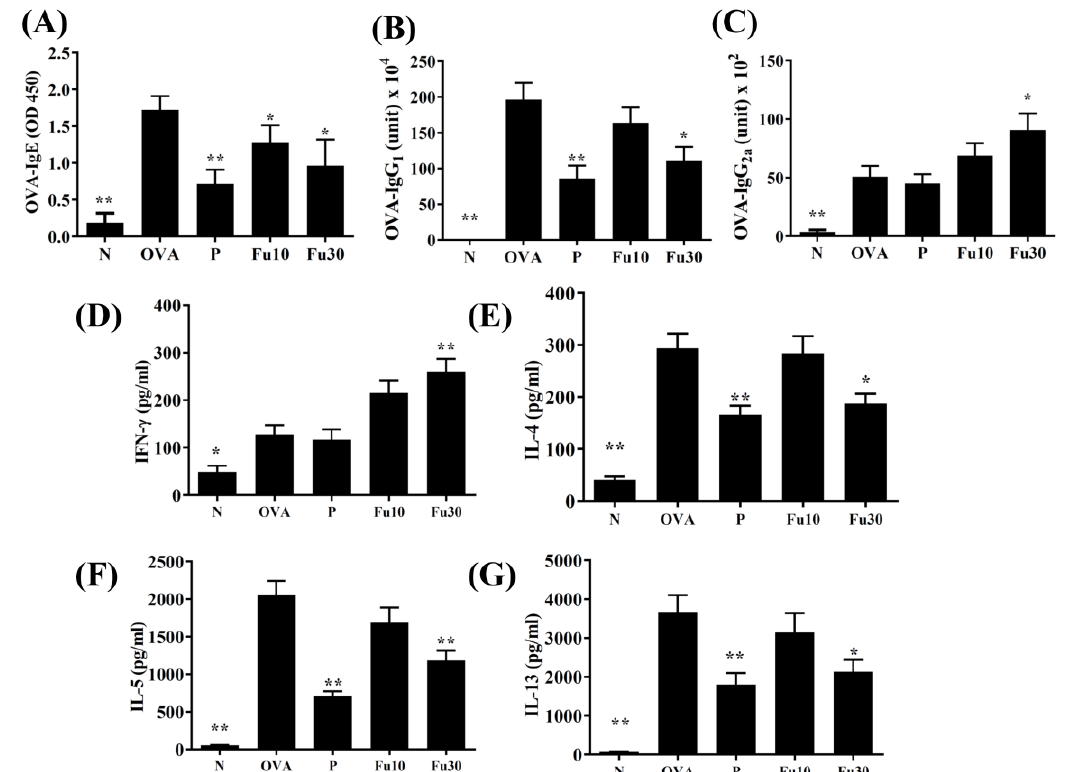
Figure 10. The Fucoxanthin (Fu) effects on OVA-specific antibodies in serum. The serum levels of ( A ) OVA-IgE, ( B ) OVA- IgG 1 , and ( C ) OVA-IgG 2a are shown for normal (N) and OVA-stimulated (OVA) mice treated without or with prednisolone (P) or fucoxanthin (Fu10 and Fu30). Fu modulated the levels of ( D ) IFN- γ, ( E ) IL-4, ( F ) IL-5, and ( G ) IL-13 produced by OVA-activated splenocytes. All data are the means ± SEM. * p <0.05, ** p <0.01 compared to the OVA control group. 10 mg/kg and 30 mg/kg fucoxanthin were named as Fu10 and Fu30, respectively. 5 mg/kg prednisolone was named as P.